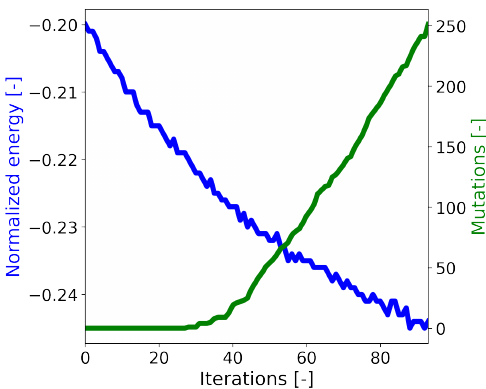
Figure 4. Convergence of the optimization algorithm and the number of mutations observed by using Algorithm 1. Note that the presented energy is the normalized one (de-biased). The code is terminated when 5 mutations are proposed on average, leading the overall mutations over 50 designs to amount to 250.